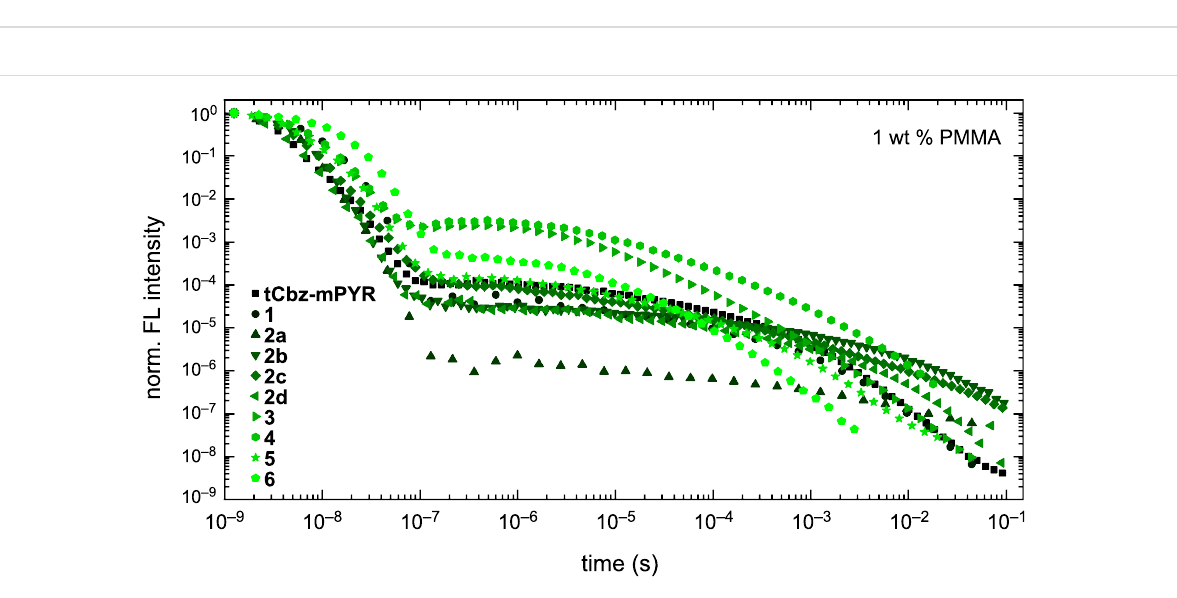
Figure 4: Fluorescence decay transients of 1 wt % PMMA films of carbazole–pyrimidine TADF compounds in oxygen-free conditions.